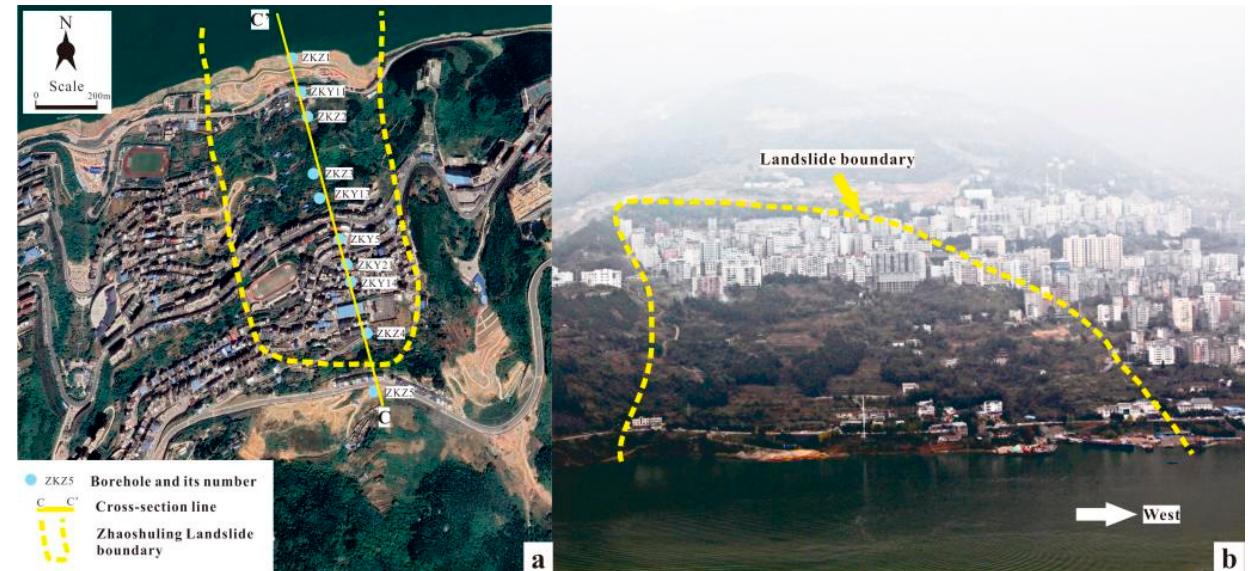
Figure 2. Landscape details of the Zhaoshuling Landslide. ( a ) Satellite image of Zhaoshuling landslide (17 May 2017, from Google Earth); ( b ) Zhaoshuling landslide photograph (16 November 2016). The landslide event was in the shape of a broken line with a slope angle varying between 25 ◦ and 40 ◦ . Three gently sloped platforms with elevations of 150 to 200 m,